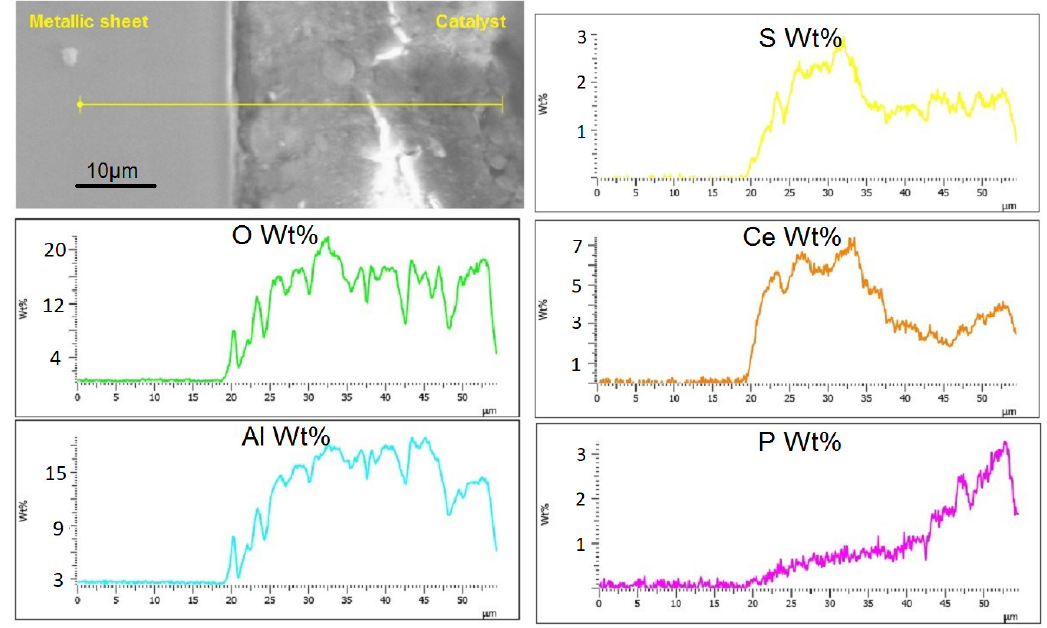
Figure 2. SEM-EDS line analysis from the vehicle-aged diesel (inlet) catalyst.